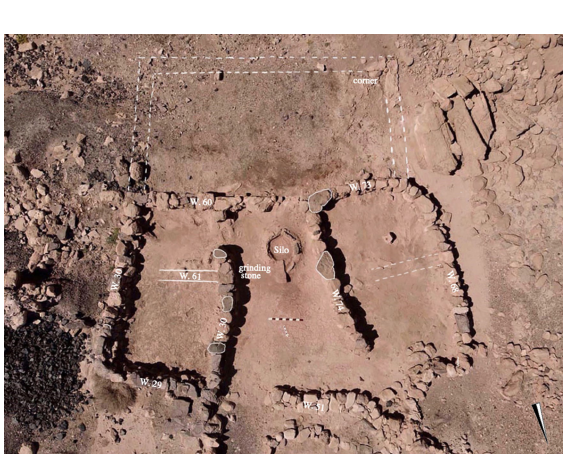
Figure 7 Timna‘ Site 30, a building similar to the “four-room house,” excavated by Conrad & Rothen- berg (see 1980, Beil. 27). Monoliths are indicated by white outlines, Wall 61, now missing, solid white line, missing partition wall in the right wing follows remains shown in Beil 27, conjectured walls of the backroom are based on the exposed corner. Scale: 1m.